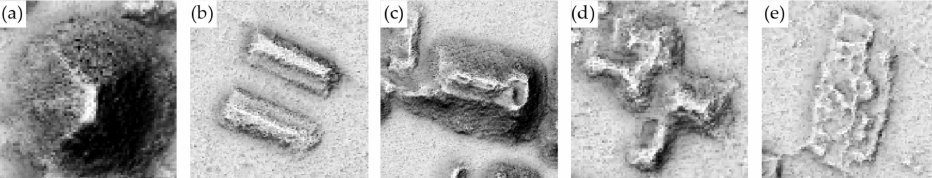
Figure 4. Di ff erent building types as evident visualization for archaeological topography (VAT) with a 0.5 m resolution. The scale varies.